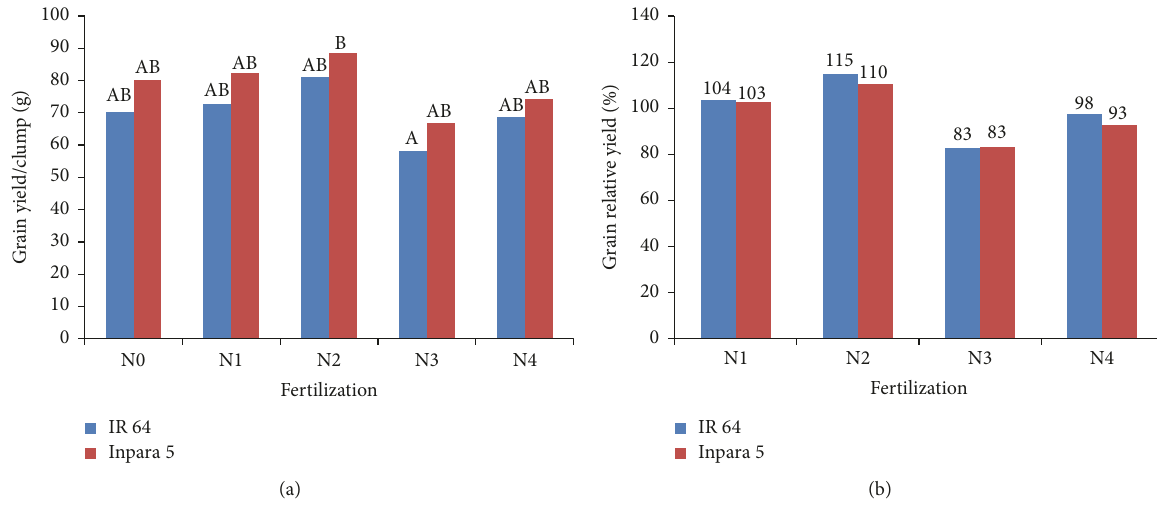
Figure2:Fertilizingtreatmenteffectfortworicevarietiesongrainyield(a)andrelativegrainyield(b)atconditionofdirtywatersubmergence